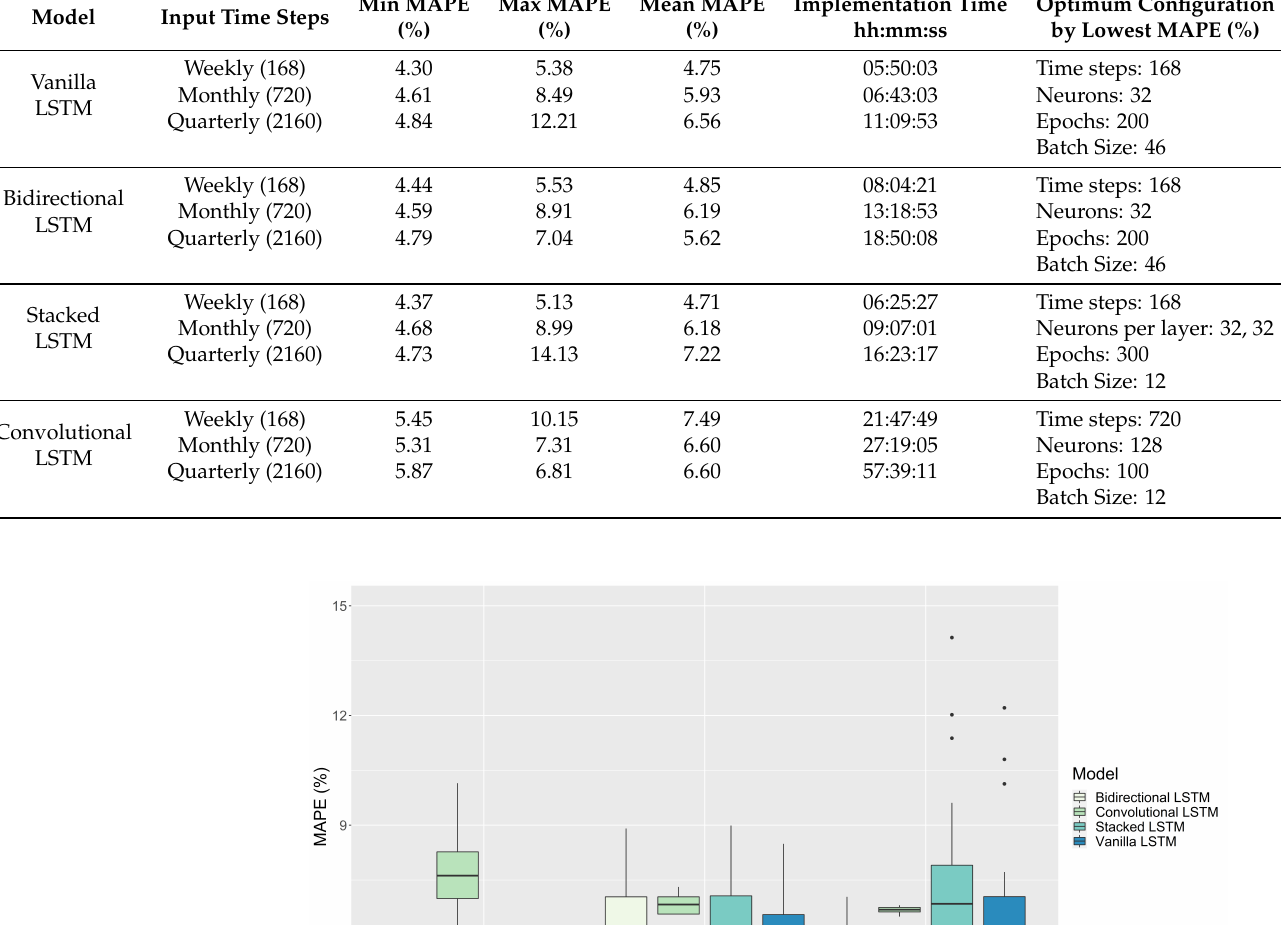
Table 3. Performance summary for all models executed according to time steps.